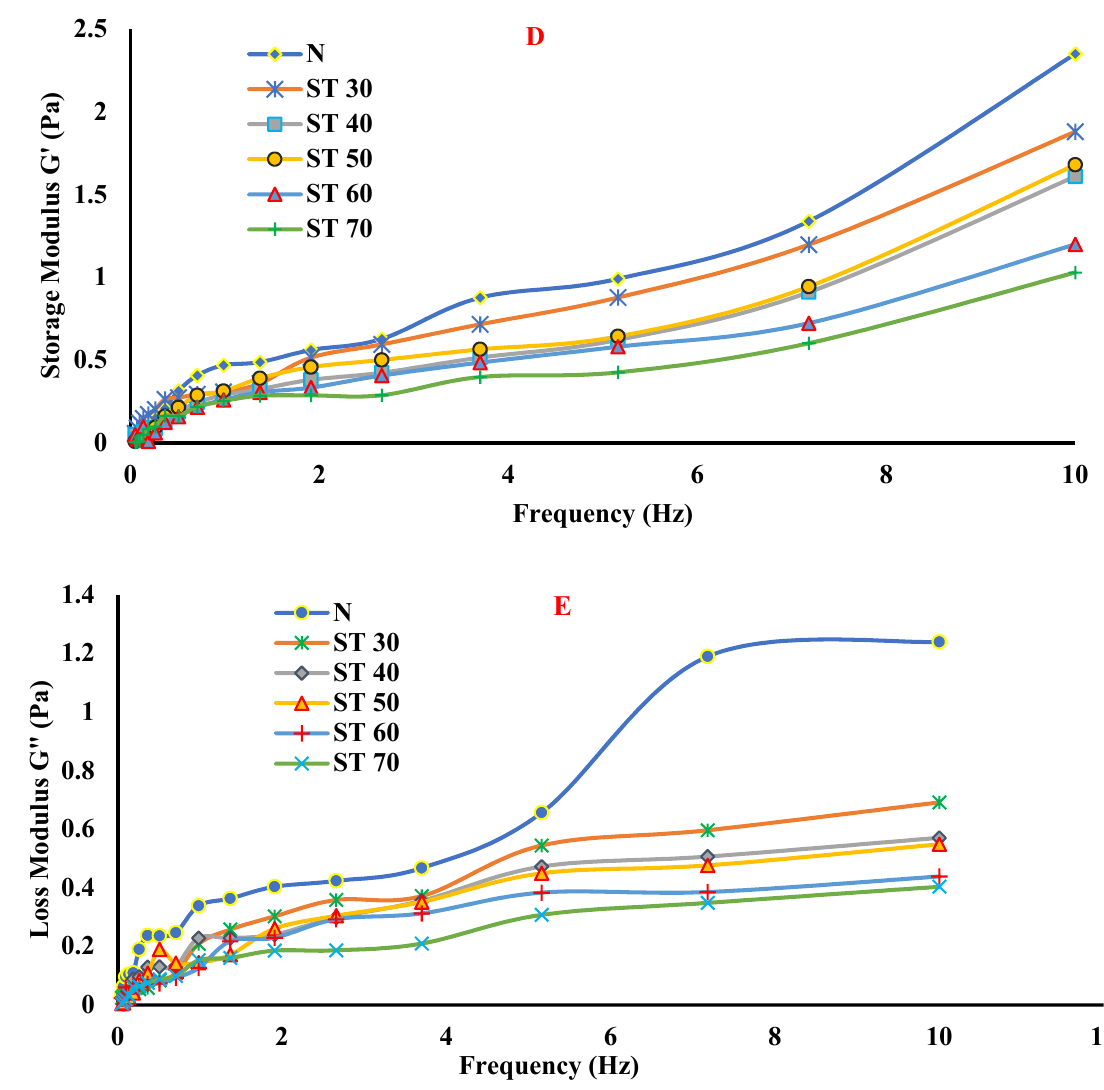
Figure 1. (i). Effect of supercritical carbon dioxide (SC-CO 2 ) treatment on gelation dynamics of plum kernel protein isolates ( A ): storage modulus, ( B ): loss modulus, ( C ): loss tangent as a temperature, N: native plum kernel protein isolate; ST 30: SC-CO 2 -treated plum kernel protein isolate at 30 °C; ST 40: SC-CO 2 -treated plum kernel protein isolate at 40 °C; ST 50: SC-CO 2 -treated plum kernel protein isolate at 50 °C; ST 60: SC-CO 2 -treated plum kernel protein isolate at 60 °C and ST 70: SC-CO 2 -treated plum kernel protein isolate at 70 °C. (ii). Effect of supercritical carbon dioxide (SC-CO 2 ) treatment on gelation dynamics of plum kernel protein isolates ( D ): frequency sweep teat as a function of storage modulus, and ( E ): frequency sweep teat as a function of loss modulus. N: native plum kernel protein isolate; ST 30: SC-CO 2 -treated plum kernel protein isolate at 30 °C; ST 40: SC-CO 2 -treated plum kernel protein isolate at 40 °C; ST 50: SC-CO 2 -treated plum kernel protein isolate at 50 °C; ST 60: SC-CO 2 -treated plum kernel protein isolate at 60 °C and ST 70: SC-CO 2 -treated plum kernel protein isolate at 70 °C.